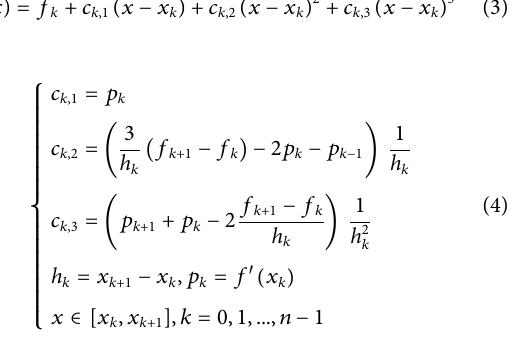
algorithm, the sequence of cycle numbers for the recon fi gured performance degradation trajectory after recon fi guration